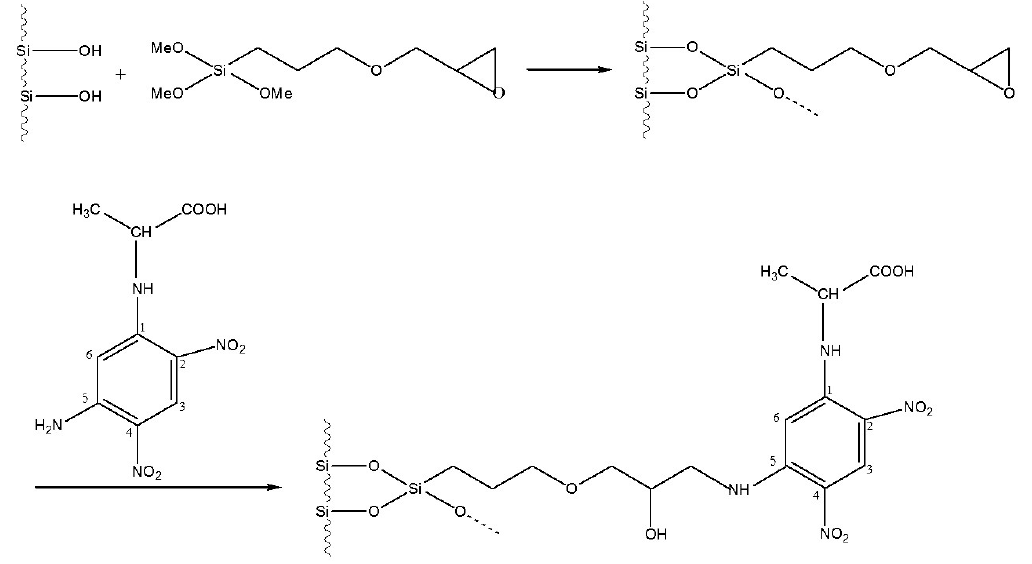
Figure 12. Linking of L - or D -DNP-alanine to silica (5 μ m) via the epoxide route [49].